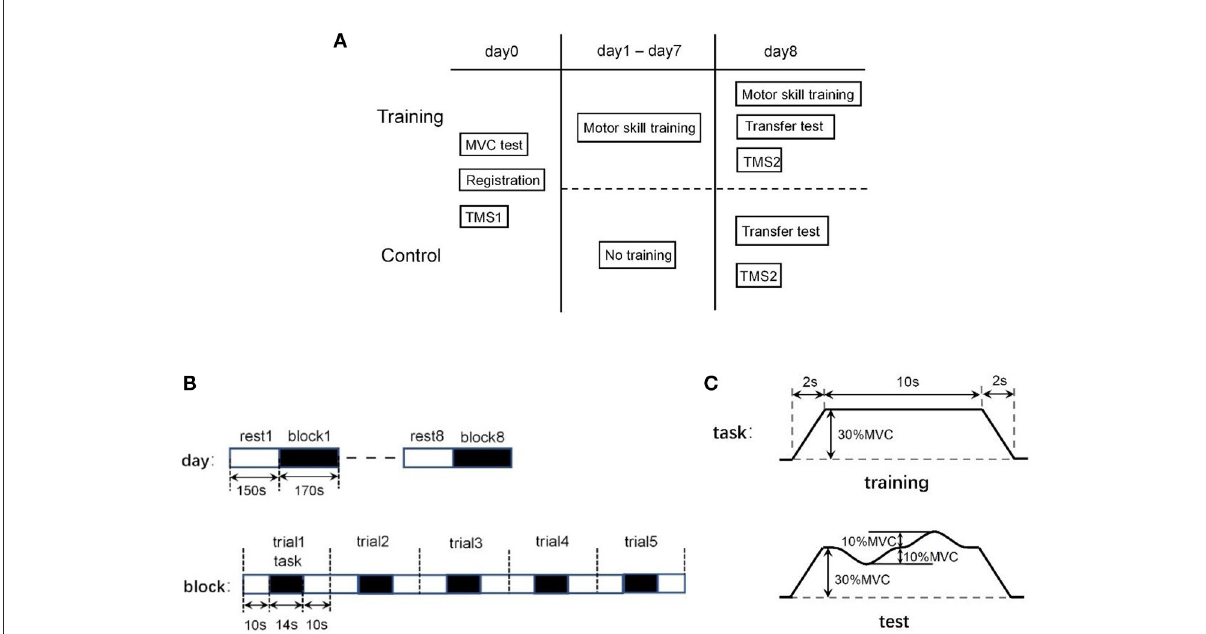
FIGURE2 (A) Arrangement of experimental paradigm. (B) Constitutions of the block-design experiment arrangement: 8 block/day (above) and 5 trail/block (below). (C) Each trial includes a force-control training task (above) followed by a 20s rest to avoid fatigue. In skill transfer experiments, the task was set into a similar but new preset (below).